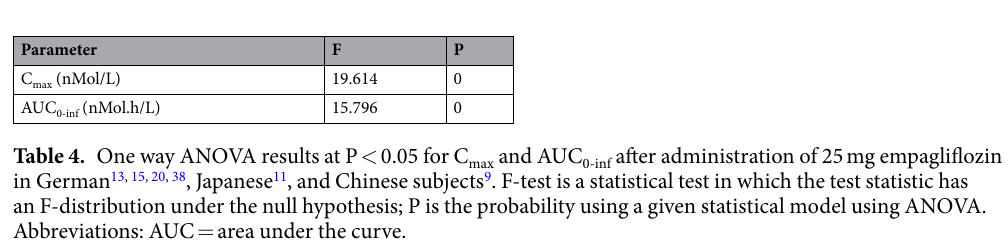
Table 3. One way ANOVA results at P < 0.05 for C max and AUC 0-inf after administration of 25 mg empagliflozin in Japanese 11 and Chinese subjects 9 . * Studied groups from pharmacokinetic studies conducted in Japanese 11 and Chinese 9 subjects using 25 mg empagliflozin showed no significant difference at P > 0.05, with P = 0.651 for Cmax and P = 0.891 for AUC 0-inf . Abbreviations: AUC = area under the curve; % C.V. = percent coefficient of variation; S.D. = standard deviation.